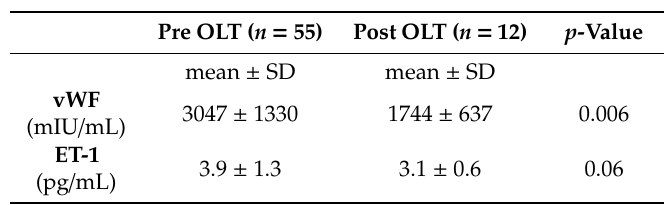
Table 2. Serum levels of endothelin-1 (ET-1) and von Willebrand factor (vWF) pre and post orthotopic liver transplant (OLT).